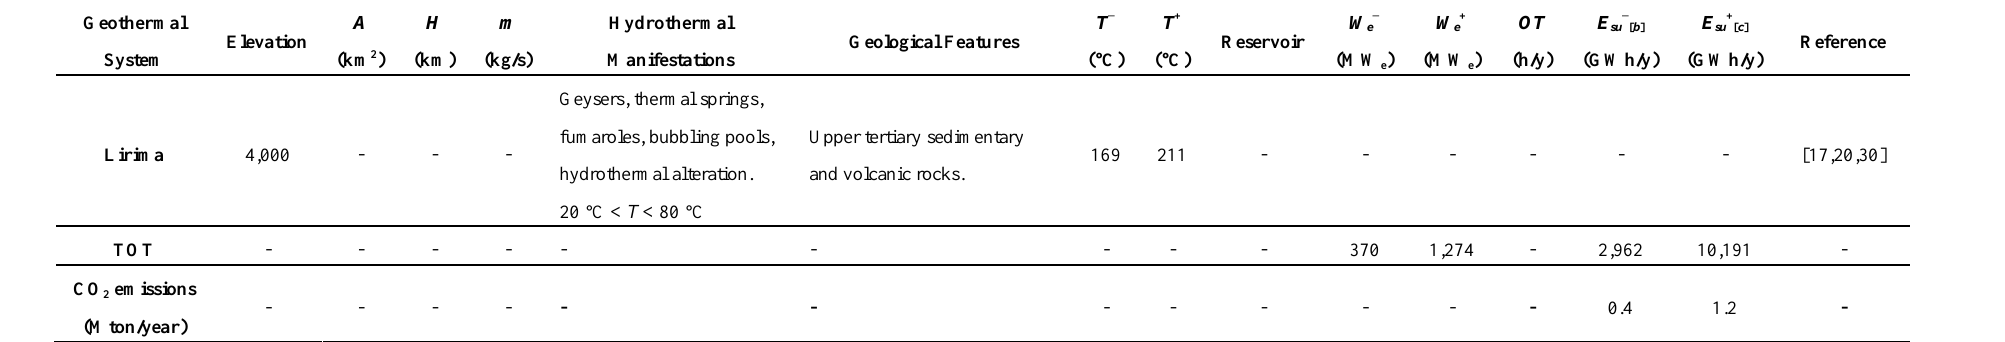
The black dashes indicate No Data